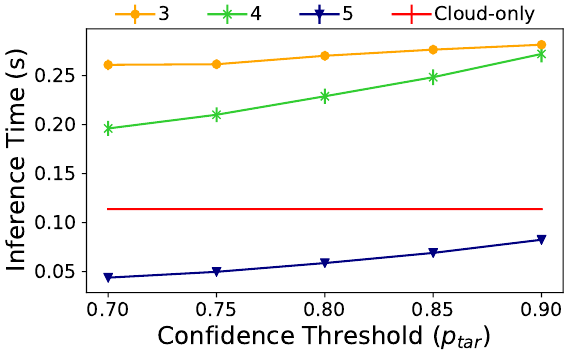
Figure 7. Overall inference time in a real edge-based scenario as a function of the confidence threshold p tar